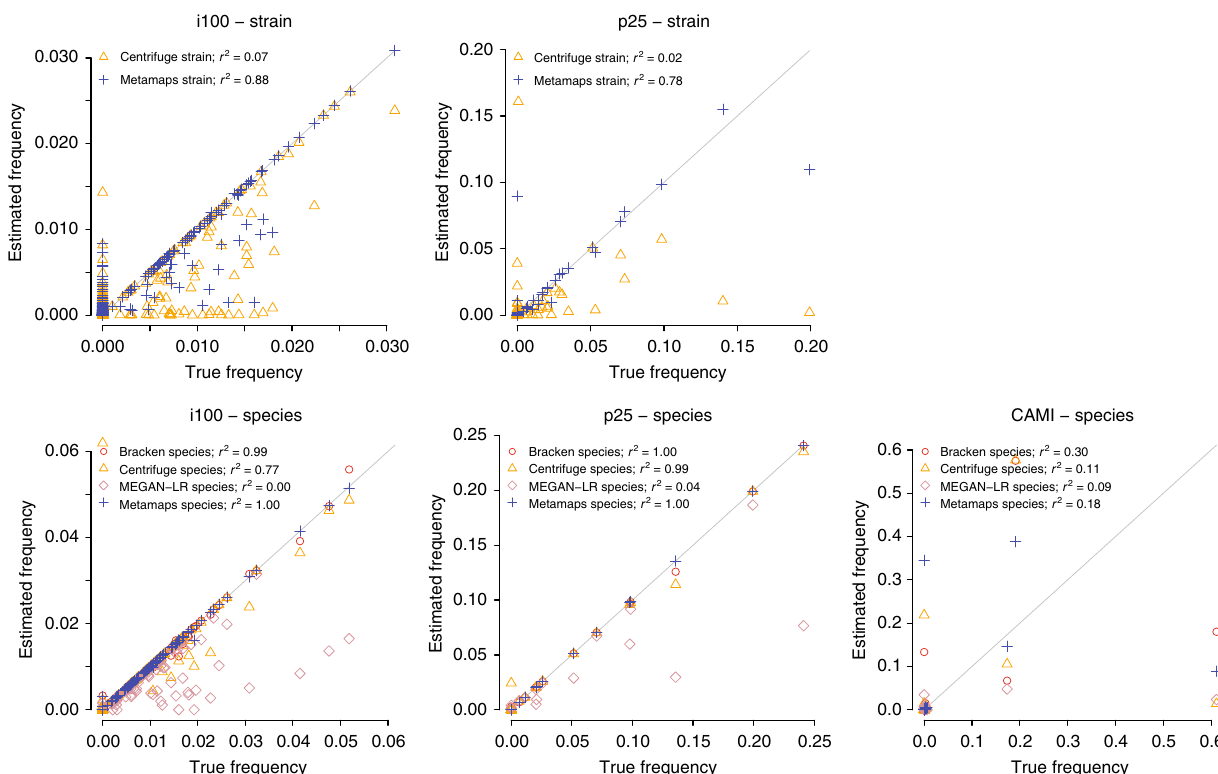
Fig. 2 Inferred compositional estimates in the experiments with simulated data (i100, p25, CAMI). The fi gure shows the compositions inferred by MetaMaps, Centrifuge, Bracken and LAST + MEGAN-LR, compared to the true underlying composition. Note that two data points representing the “ Unclassi fi ed ” bin in the Centrifuge i100 and p25 strain-level experiments and two data points representing the “ Unclassi fi ed ” bin in the LAST + MEGAN- LR species-level experiments lie outside of the plotted area